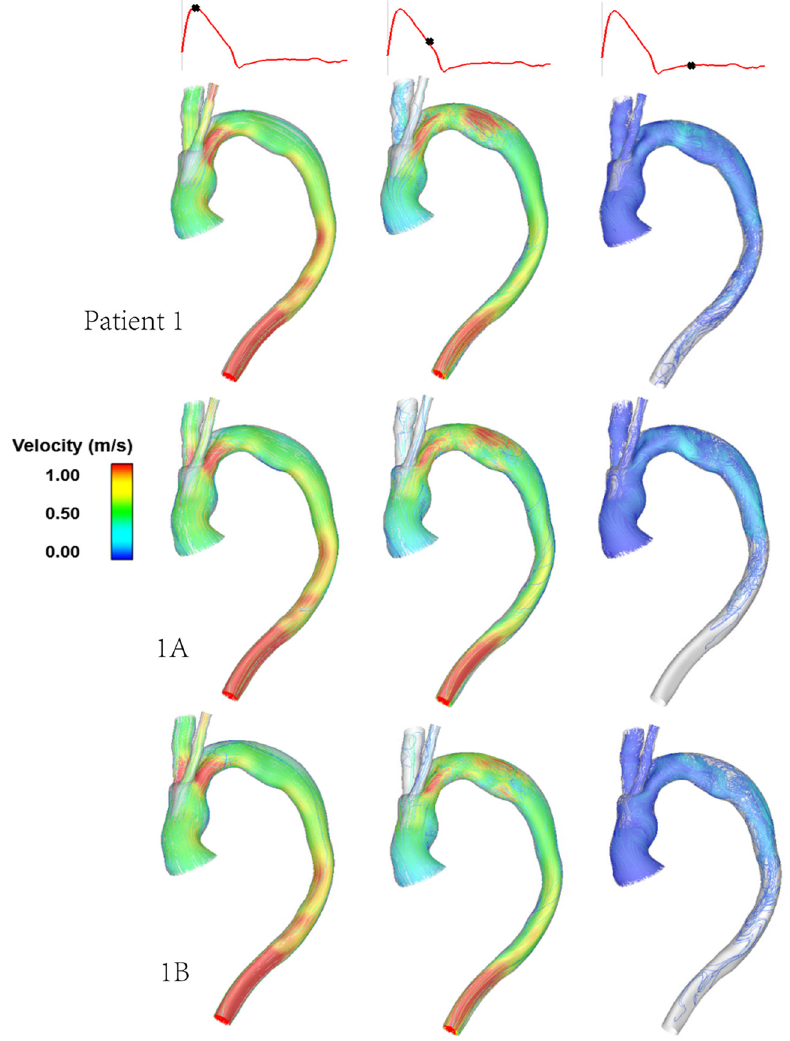
Figure 4. Comparison of instantaneous velocity streamlines obtained for cases of different diameters of inner tunnel branches for the same patient geometry, at three characteristic time points in the cardiac cycle. Patient 1 ( top row), model 1A ( middle row) and model 1B ( bottom row) have inner tunnel diameters of 12 mm, 10 mm and 8 mm, respectively.